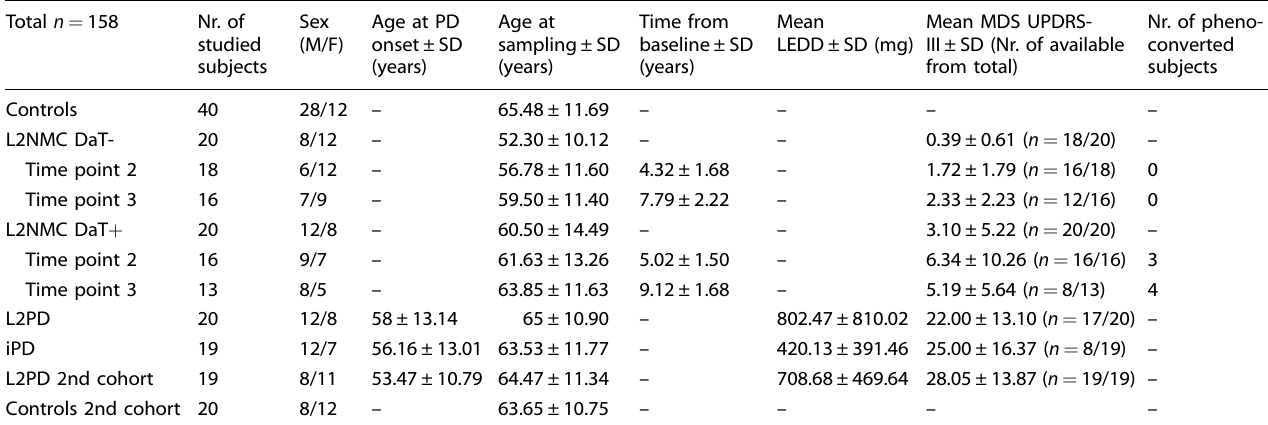
Table 1. Clinico-demographic data of